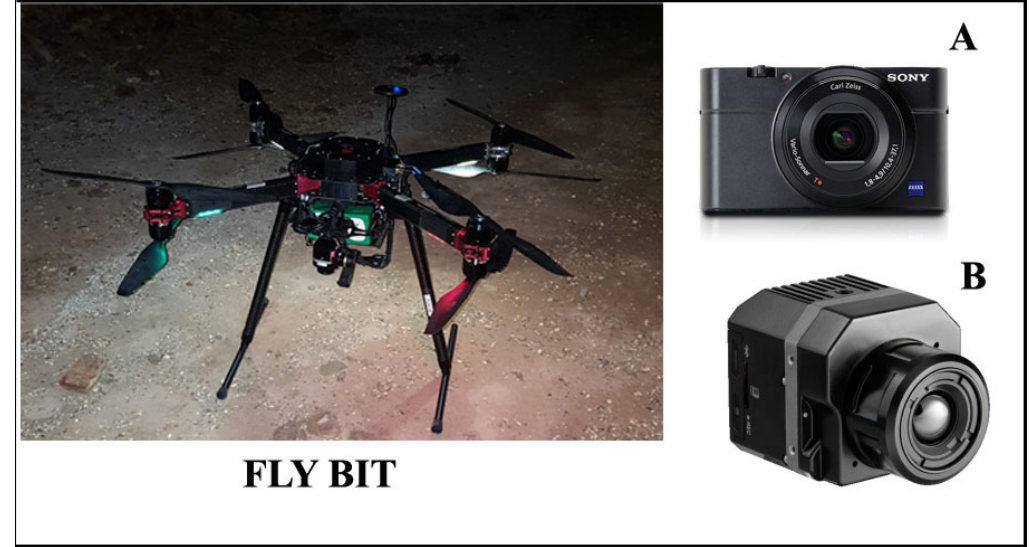
Figure 5. FlyBit octocopter and equipment. ( A ) Sony Alpha 6000 camera; ( B ) FLIR VUE PRO R thermal imaging camera.